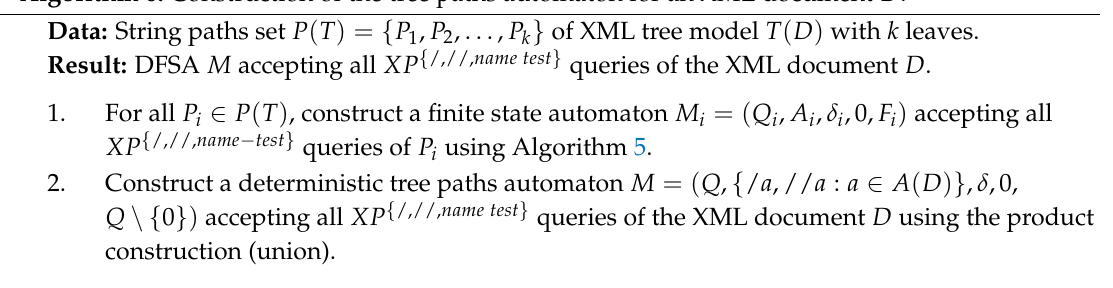
Algorithm 6: Construction of the tree paths automaton for an XML document D .